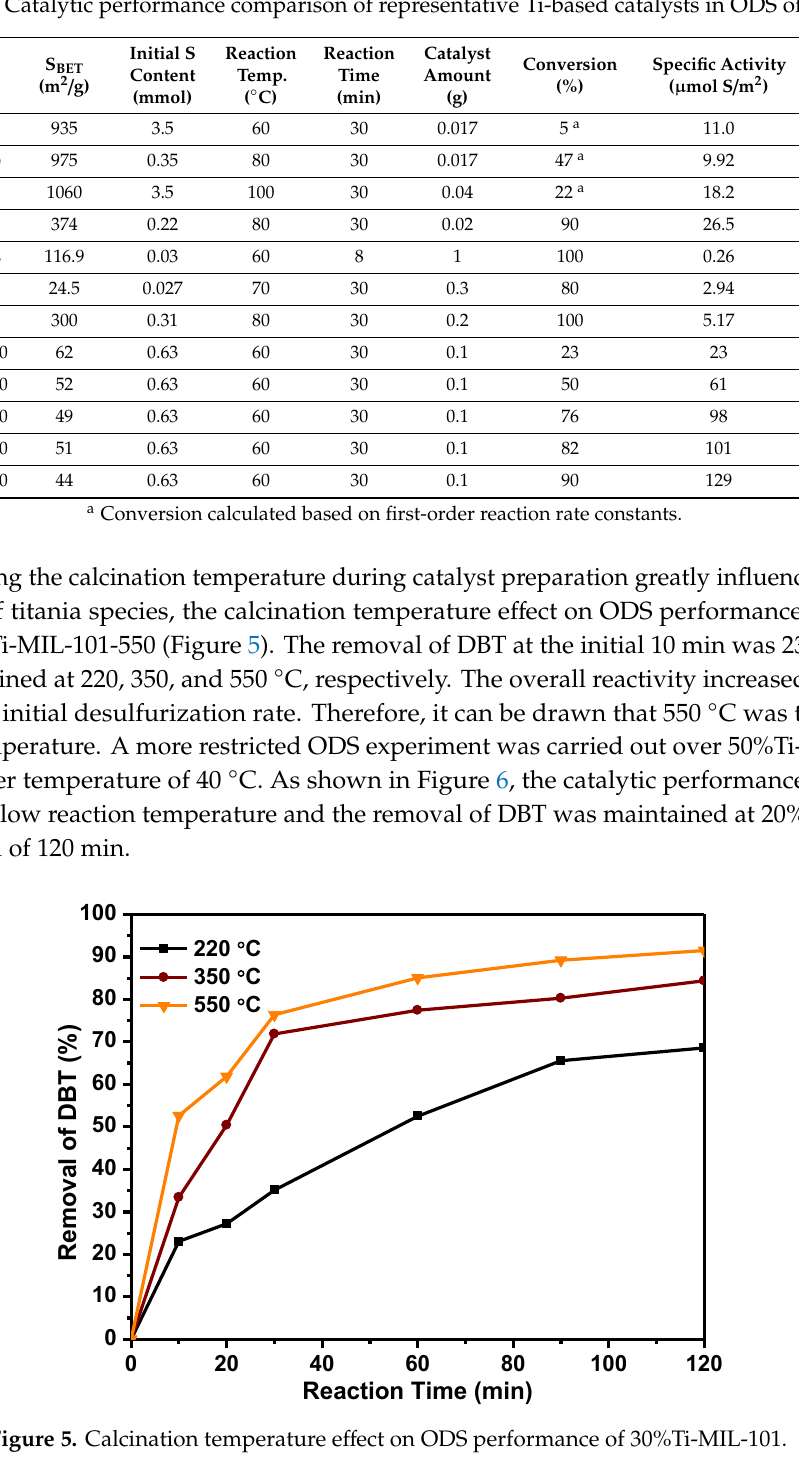
Table 3. Catalytic performance comparison of representative Ti-based catalysts in ODS of DBT.